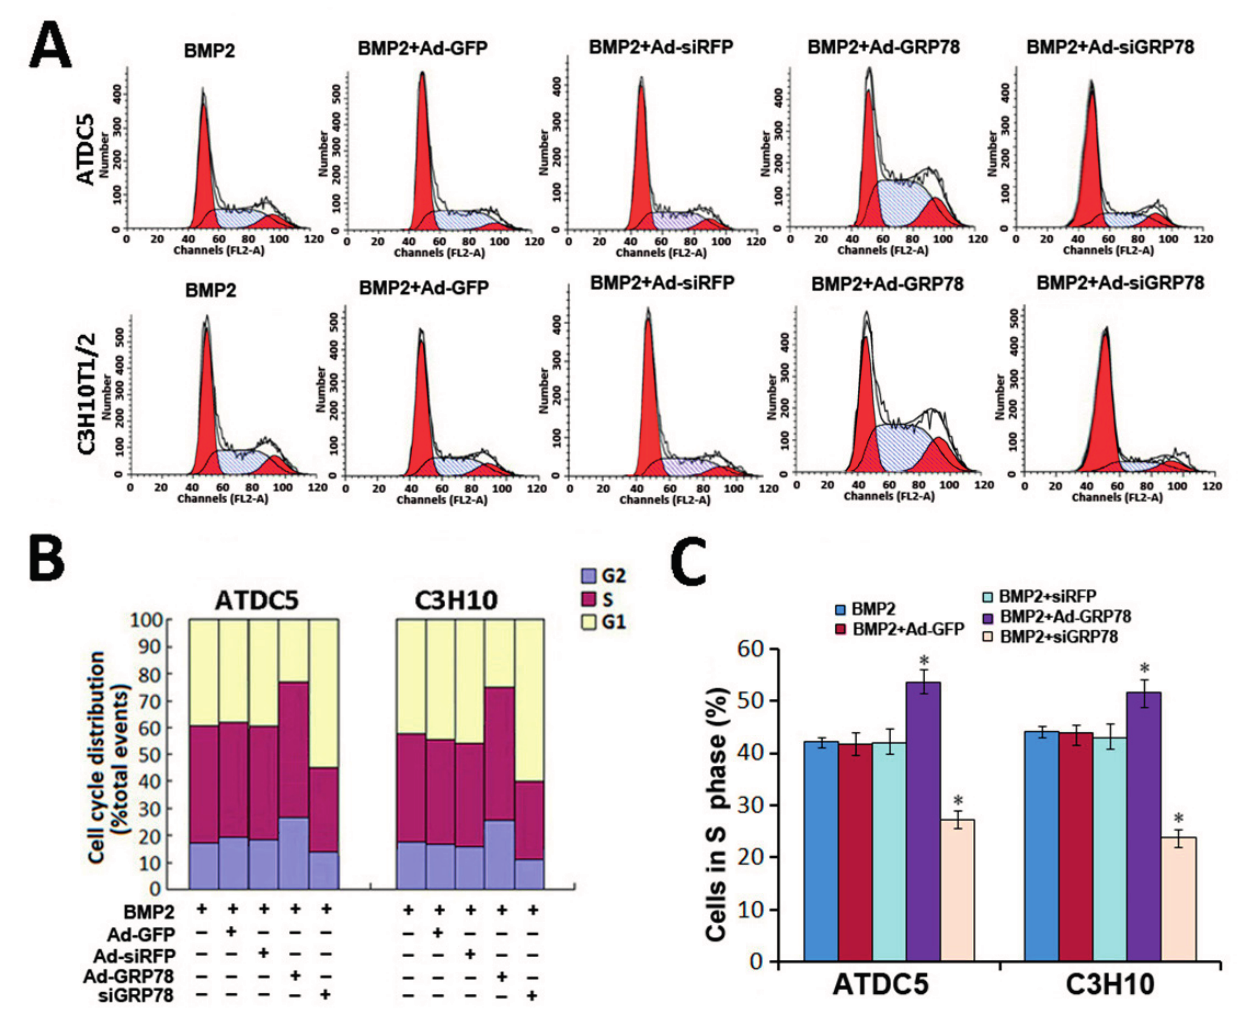
Figure 4. Cellular proliferation analysis by FCM. ( A ) Flow cytometry images with propidium iodide staining and analysis on cell cycle distribution. Micromass culture of ATDC5 cells and C3H10T1/2 were treated with BMP2 (300 ng/mL)/BMP2 + Ad-GFP/ BMP2 + Ad-siRFP / BMP2 + Ad-GRP78 / BMP2 + Ad-siGRP78. Flow cytometry